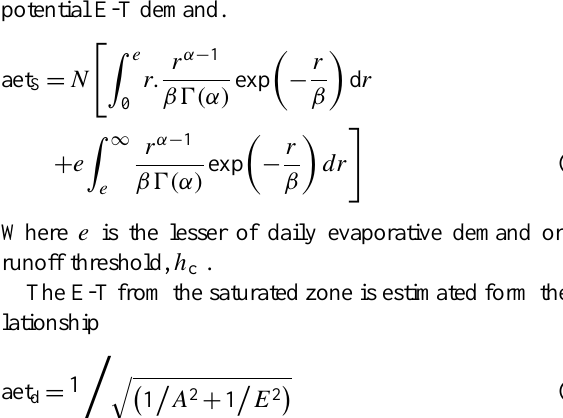
Figure 8. Empirical relationship between forecast pool frequency and the average number of Fig. 8. Empirical relationship between forecast pool frequency and dry months (Precip < 0.6 Pot E-T) for current climate and with a 2 o C temperature rise the average number of dry months (Precip < 0.6 Pot E-T) for current climate and with a 2 ◦ C temperature